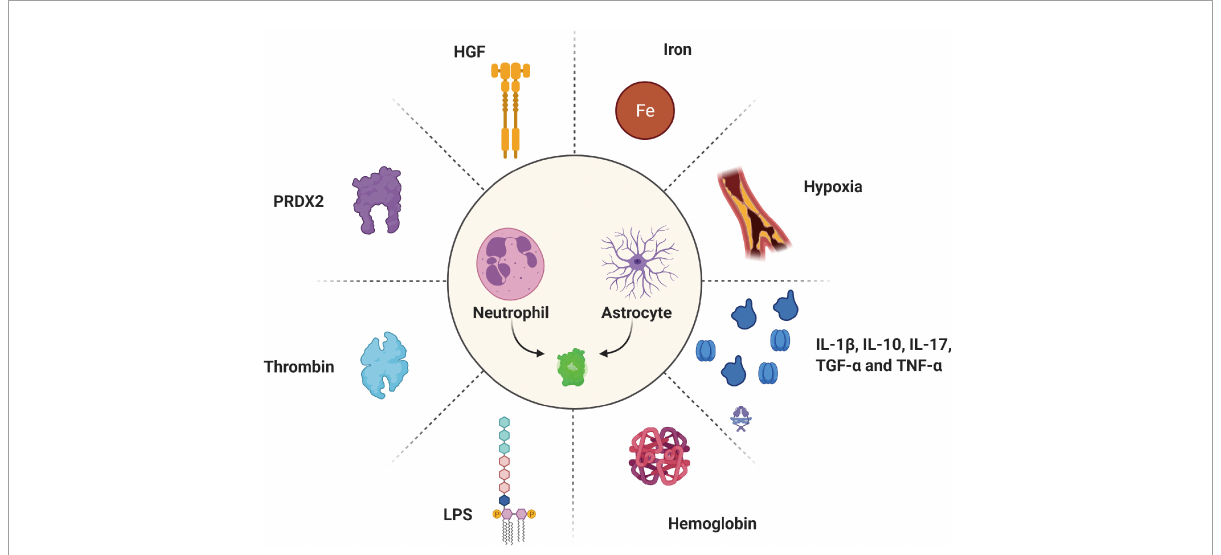
FIGURE3 Various inducers regulate the expression of LCN2 under pathological conditions. HGF, hepatocyte growth factor; PRDX2, peroxiredoxin 2; LPS, lipopolysaccharides.